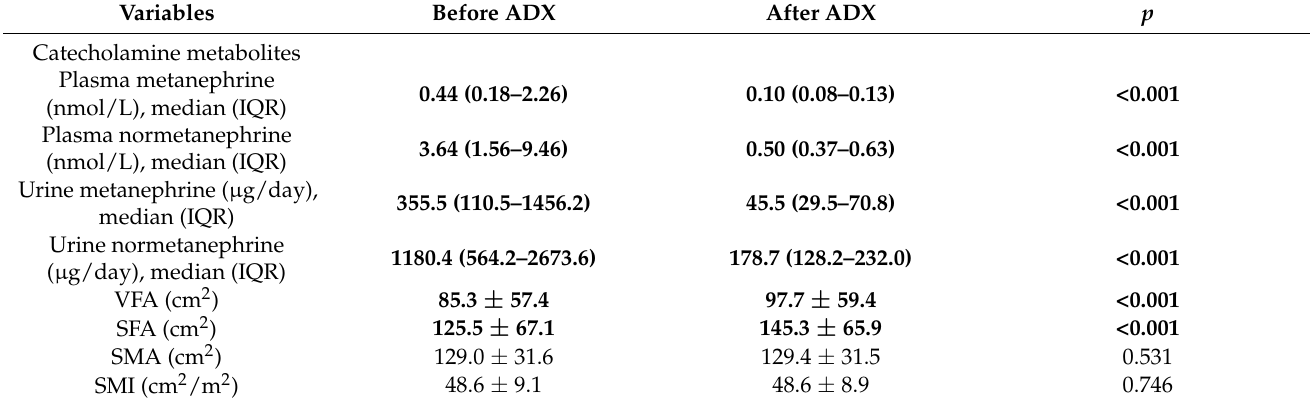
Table 2. Changes in computed tomography-determined body composition and catecholamine metabolites before and after adrenalectomy in patients with